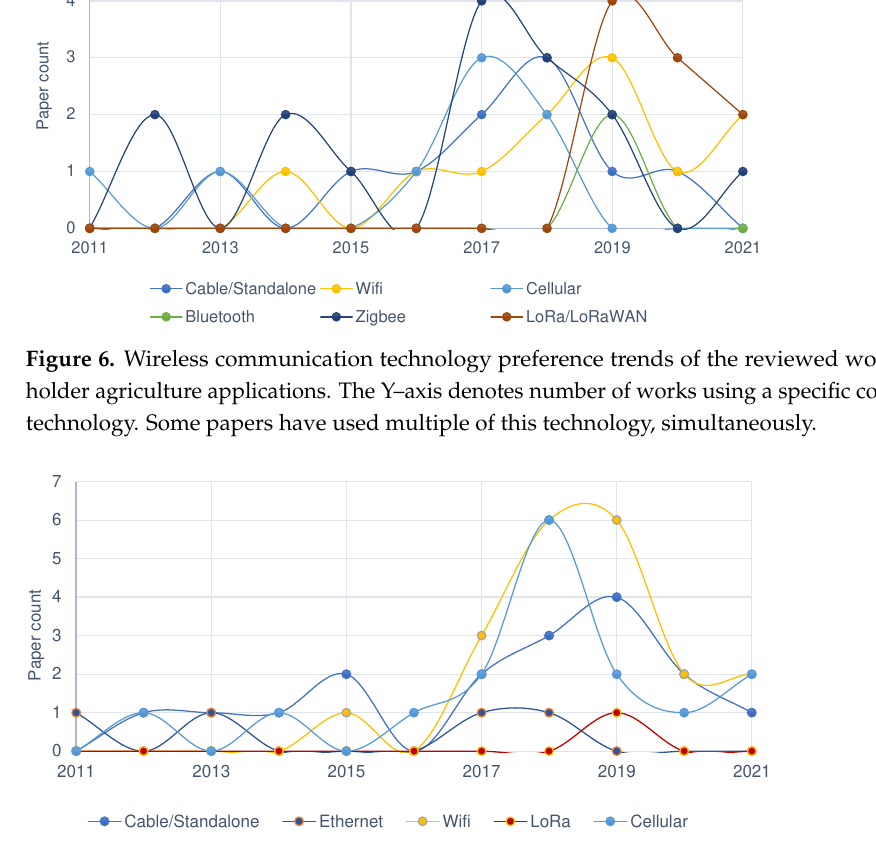
Figure 7. Trends of common backhaul communication standards use in smallholder agriculture